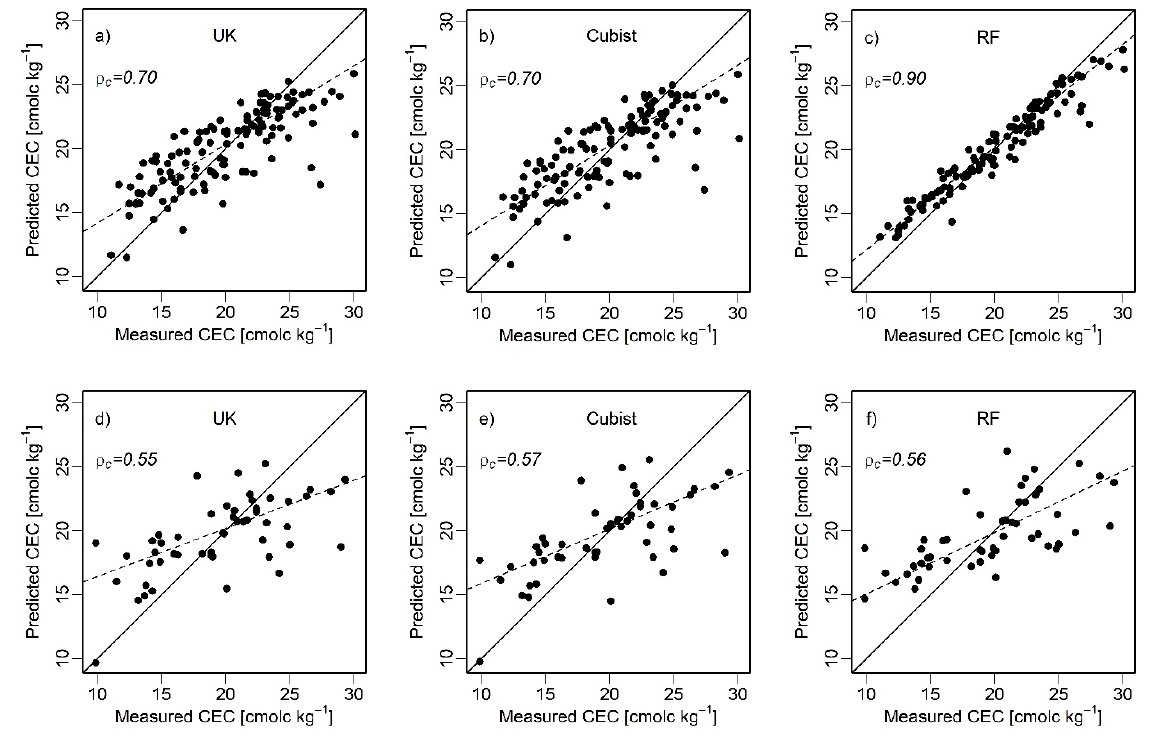
Figure 6. Scatter plots of measured vs. predicted CEC based on calibration ( a – c ) and validation data ( d – f ) for Universal kriging (UK), Cubist, and random forest (RF) models. The solid line indicates a line of concordance or a 1:1 relationship. The dashed line indicates the line of best fit.